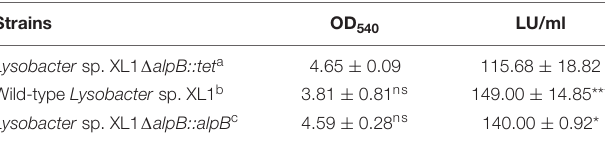
TABLE 2 | Effect of alpB gene knockout on Lysobacter sp. XL1 growth and bacterial activity. Strains OD